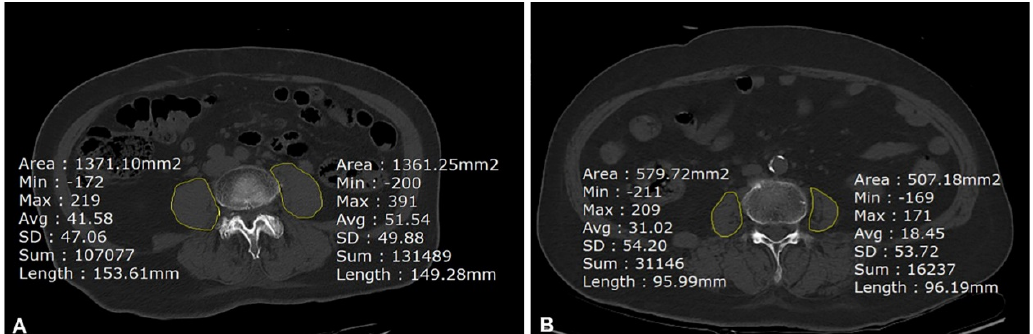
Figure 2. Cross-sectional images of the psoas muscle in pelvic bone CT. Cross-sectional image from the pedicle level of L4 axial view of pelvic bone CT. Right and left psoas muscle areas are measured using free ROI and averaged. Cross-sectional image of psoas muscle for ( A ) measured PMA of the patients in the 5th quintile group and ( B ) measured PMA of the patients in the 1st quintile group. CT, computed tomography; ROI, region of interest; PMA, psoas muscle area; BSA, body surface